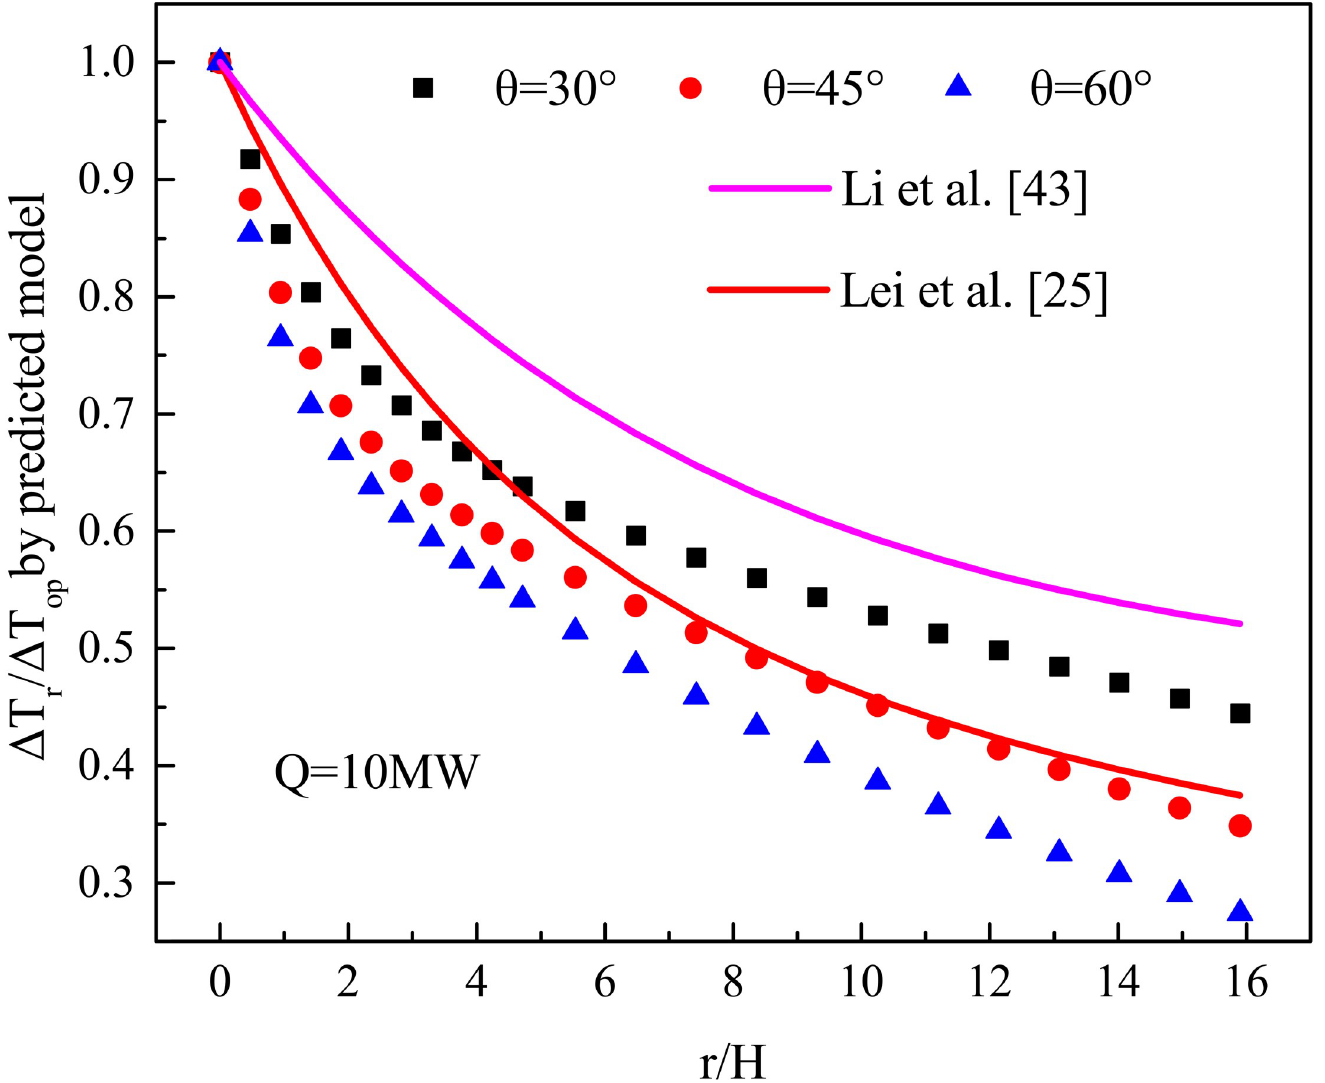
Fig 15. Comparisons between current research and published data [25,